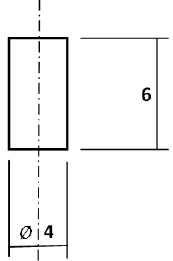
Figure 7: Specimen for compression test (C).